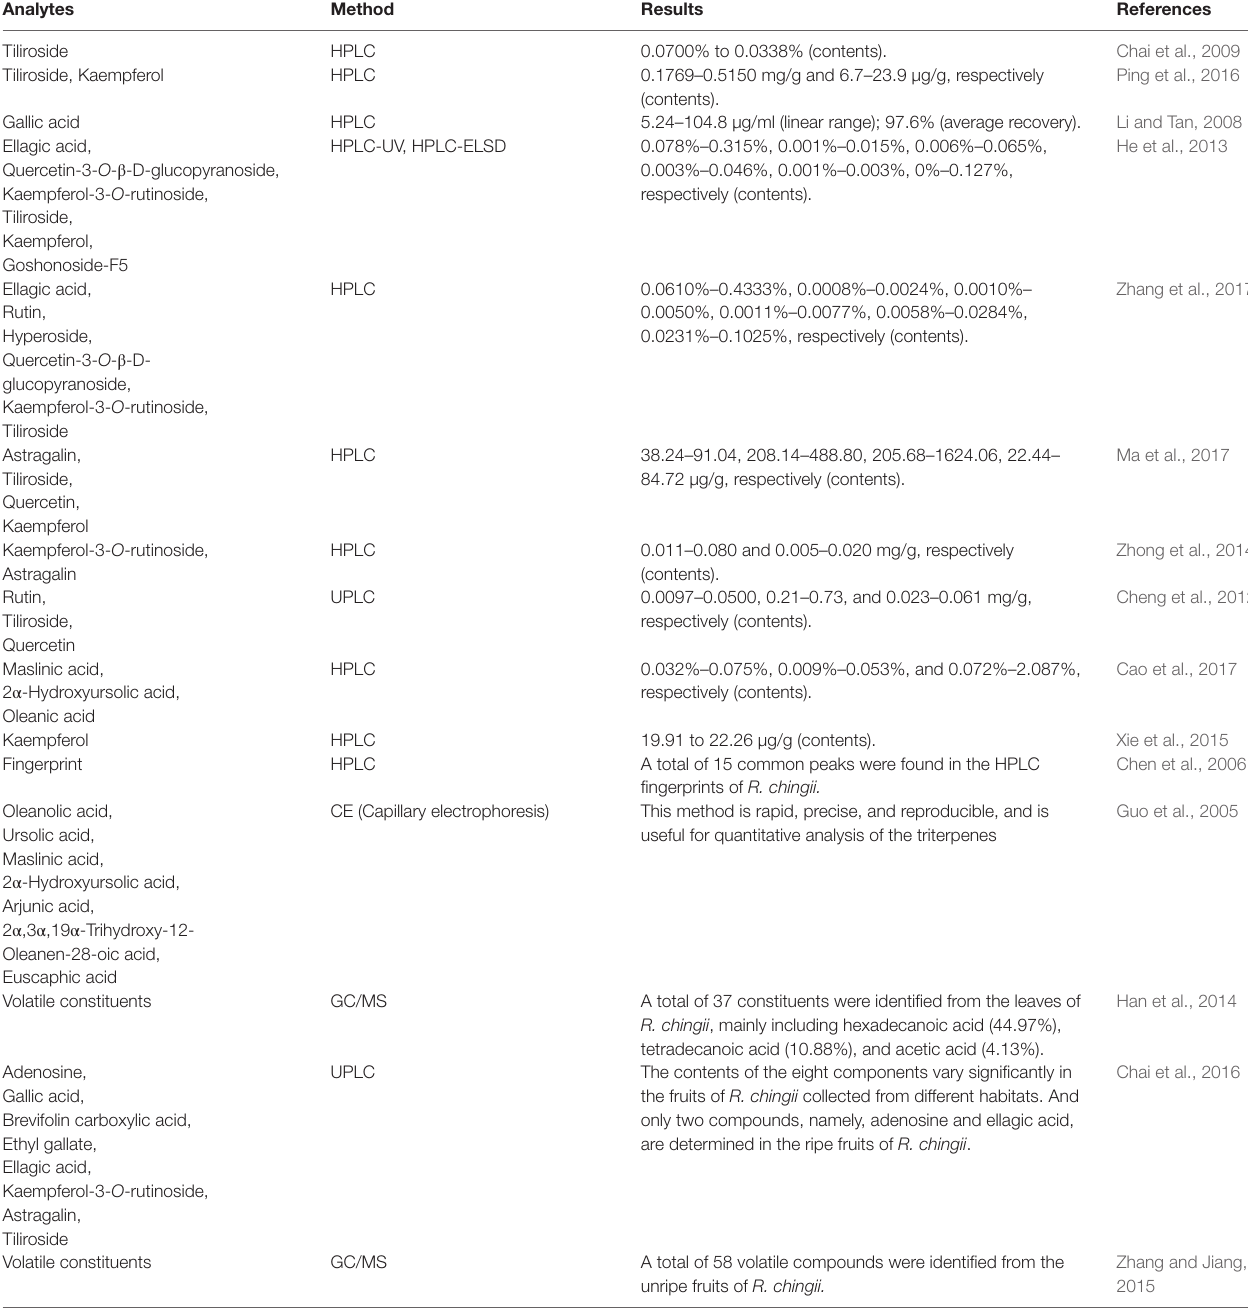
TABLE 3 | Quantitative analysis for the quality control of R. chingii